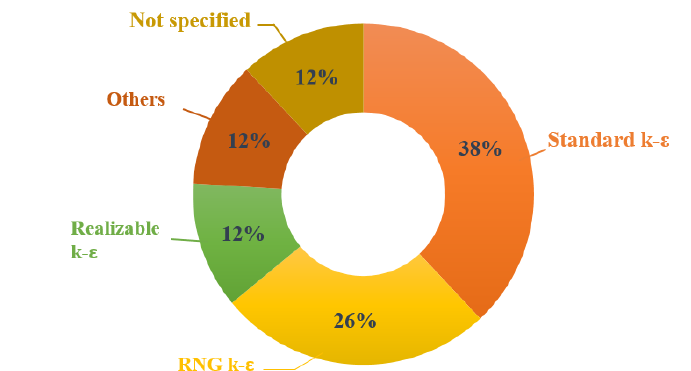
Figure 16. Types of turbulence models used in the investigated